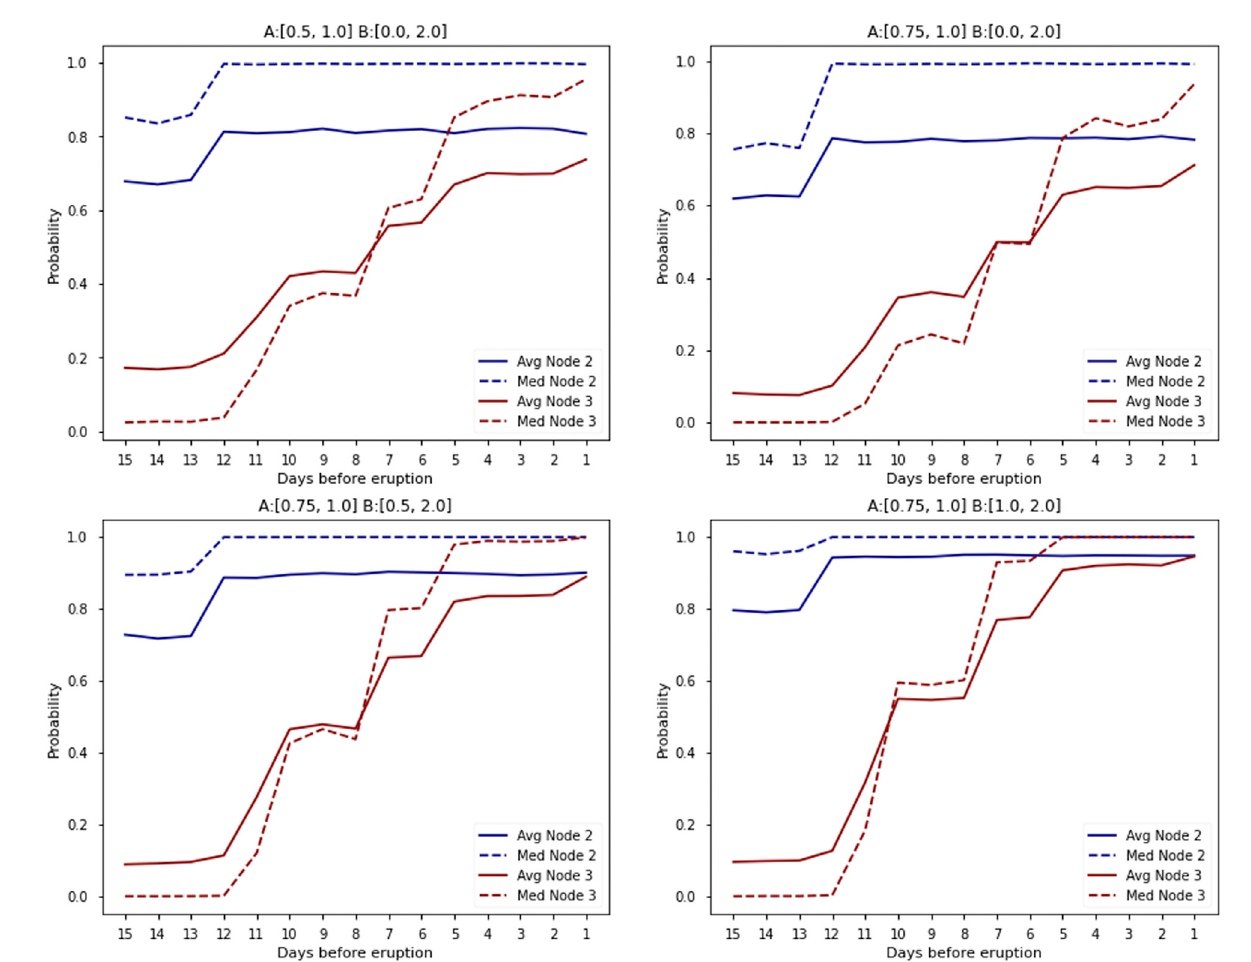
FIGURE 5 | Time evolution of BETEF_AVF output probabilities for magmatic unrest and eruption forecasting for the Birkenhead scenario for a range of a and b parameter combinations.